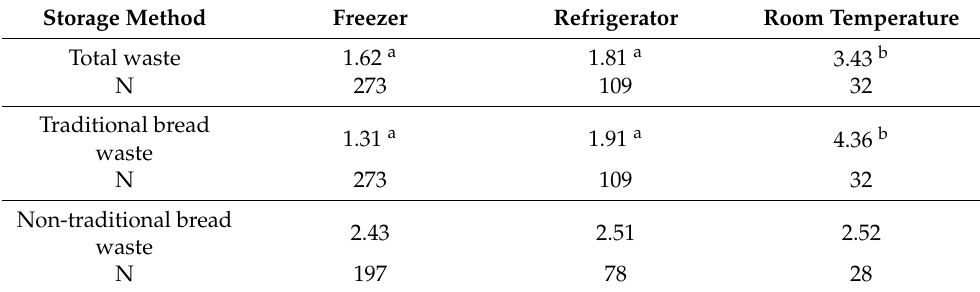
Table 4. Mean waste percentages of different bread categories based on storage